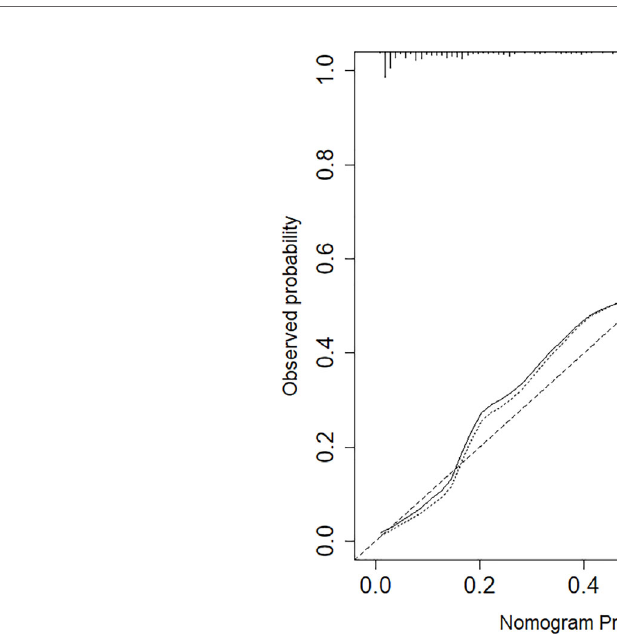
FIGURE 3 | Nomogram calibration between the predicted risk and observed incidence. Calibration curves depict the calibration of models in terms of the agreement between the predicted risks of ENE and observed outcomes of ENE. The y-axis represents the actual ENE rate. The x-axis represents the predicted ENE risk. The diagonal dotted line represents a perfect prediction by an ideal